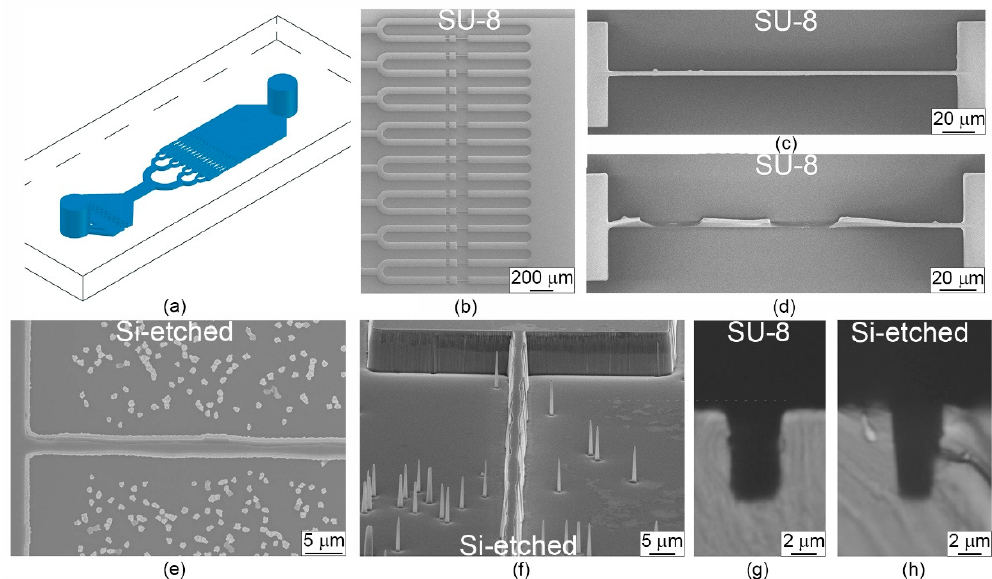
Figure 1. Microfluidic device for mimicking microcapillaries of the circulation system: ( a ) schematic view; ( b ) total view of 16 microchannels on the SU-8 mold; ( c ) example of a SU-8 microchannel on the new mold; ( d ) example of a SU-8 microchannel after three months of usage; ( e ) top view and ( f ) side view of a channel on the Si-etched mold; ( g ) cross section of a PDMS replica fabricated with SU-8 mold; ( h ) cross section of a PDMS replica fabricated with Si-etched mold. All images were obtained by scanning electron microscope.